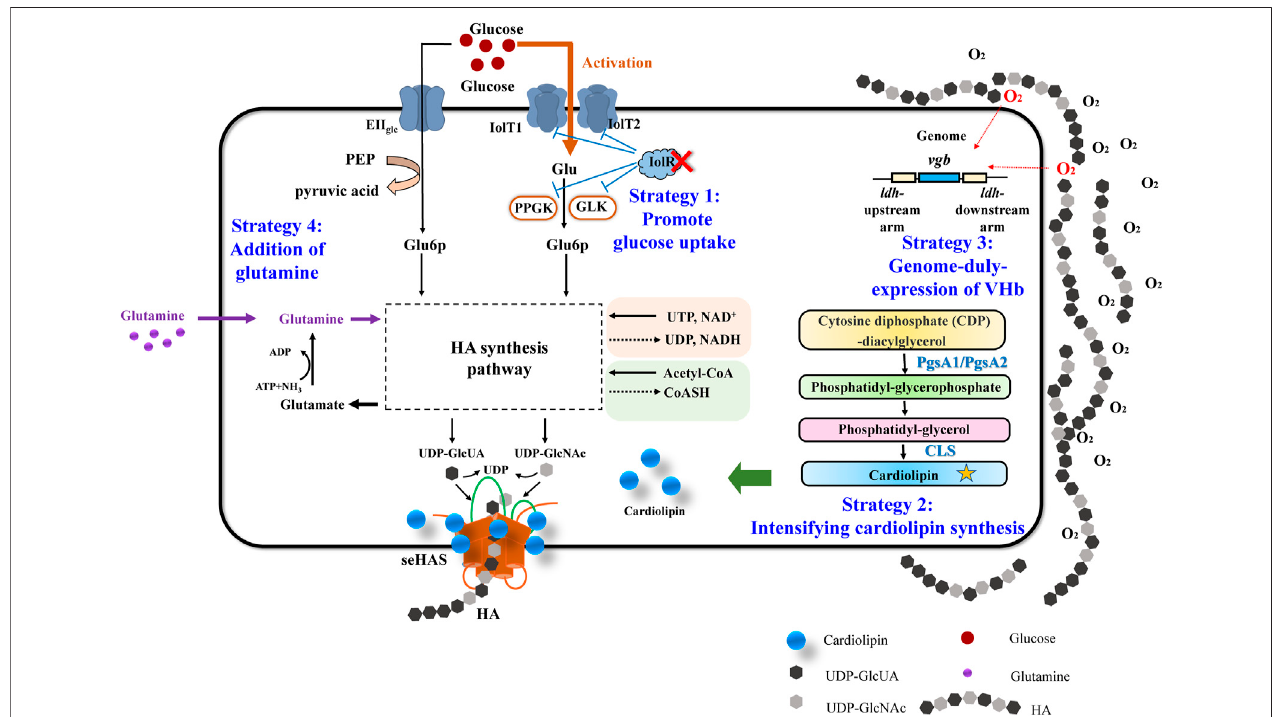
FIGURE 1 | Overview of the four indirect metabolic strategies to promote HA production in this work.